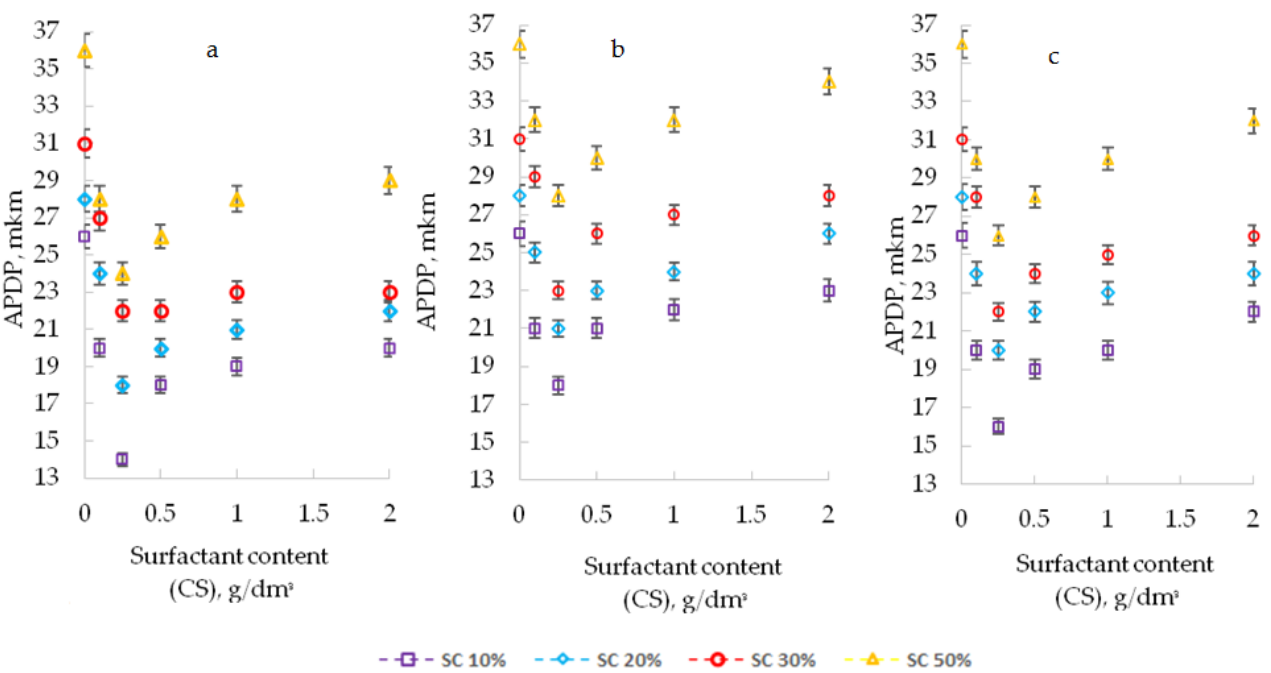
Figure 1. Influence of the type and content of surfactants (CS) on ADPD at different SC (10–50%); ( a ), PEPA; ( b ), AS-1; and ( c ), Telaz.